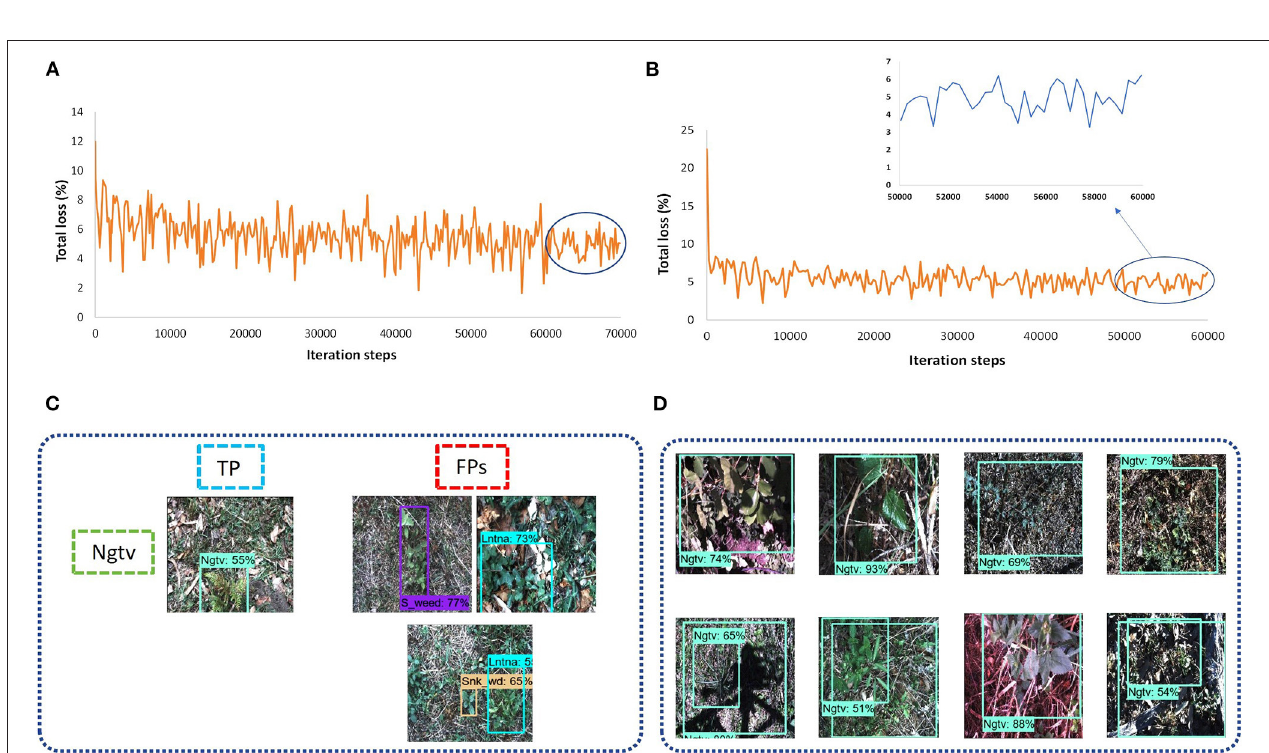
FIGURE 3 | Performance of the You look only Once (YOLO)-v4 model: (A) loss plot; (B) true positives for parthenium, rubber vine and siam weed; (C) examples of undetected images for lantana and snake weed classes.